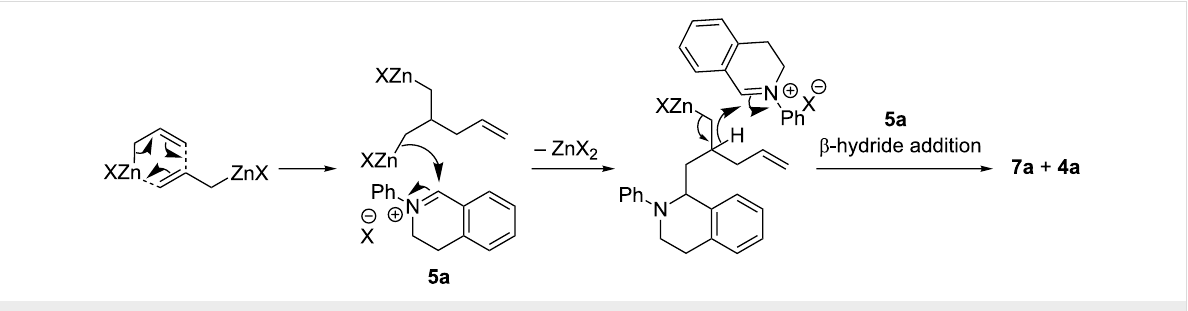
Figure 4: Mechanism for dimerisation of the allylzinc halide and β -hydride addition to 5a [36].